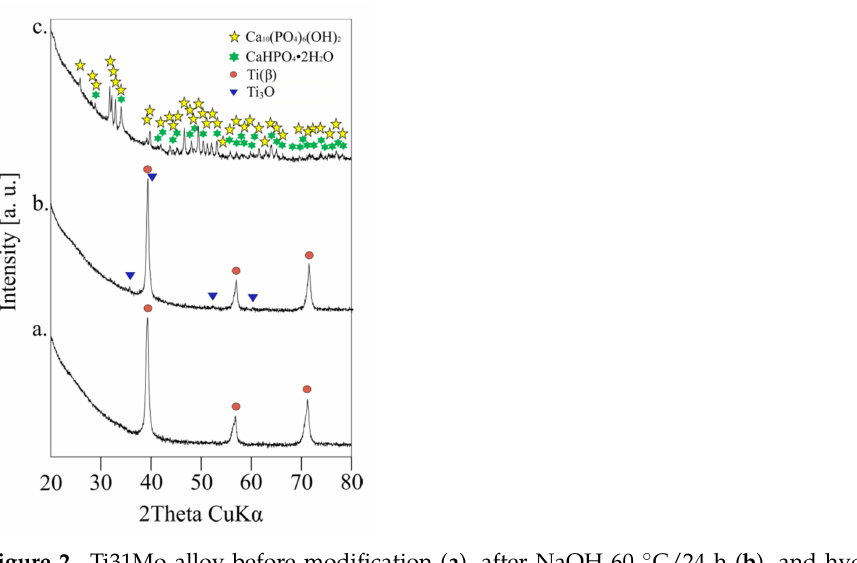
Figure 2. Ti31Mo alloy before modification ( a ), after NaOH 60 ◦ C/24 h ( b ), and hydrothermal treatment ( c ). Table 1. The structural parameters of Ti31Mo alloys before modification, after NaOH 60 ◦ C/24 h, and hydrothermal